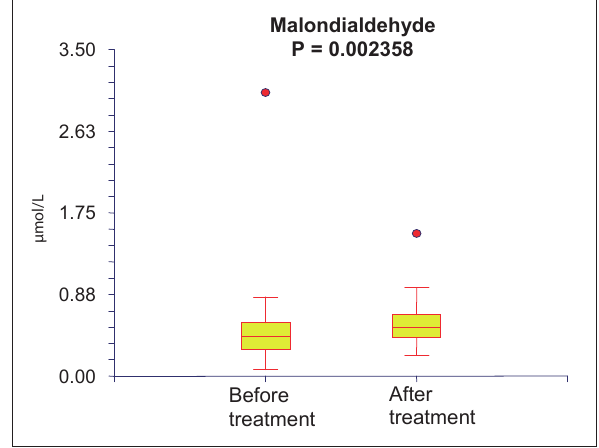
Fig. 3. Levels of MDA in serum before and after RH treatment.